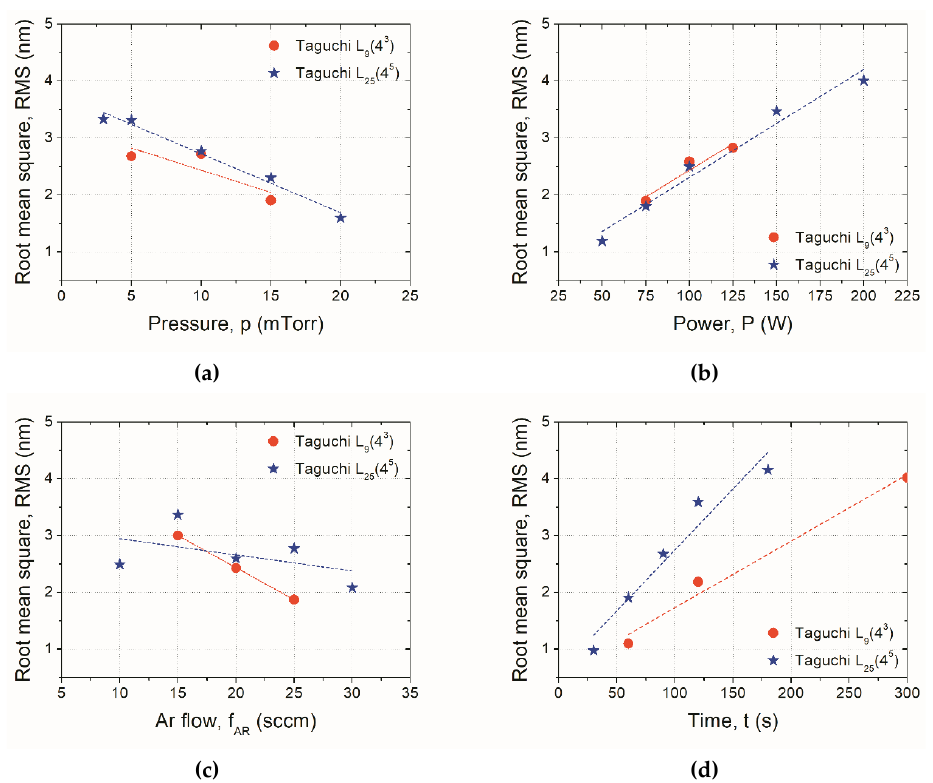
Figure 3. Influence of magnetron sputtering process’ parameters onto roughness of aluminum films: ( a ) pressure in the reactive chamber, ( b ) DC power applied to the electrodes, ( c ) argon flow, and ( d ) time of the process.